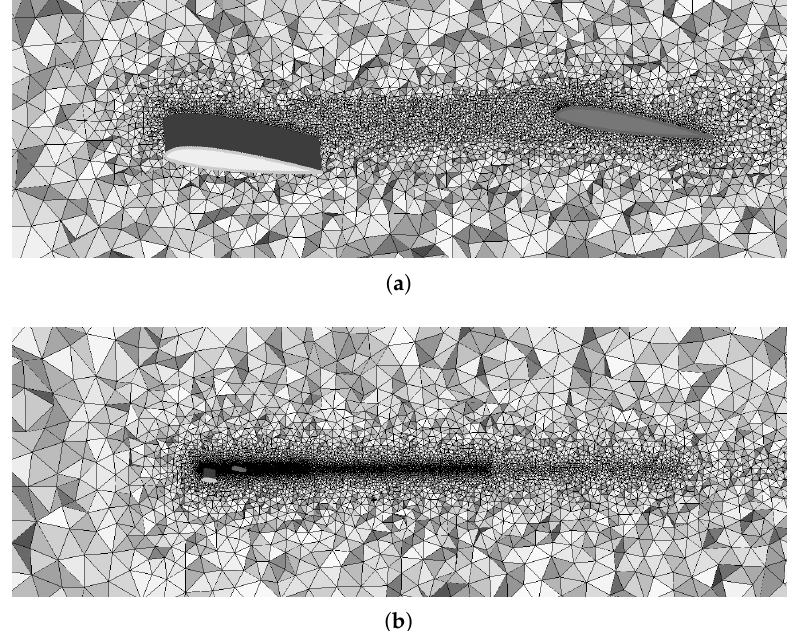
Figure 5. Cut-section of the 3D grids: ( a ) close-up of both wings; and ( b ) overview of both wings and grid refinement in the wake